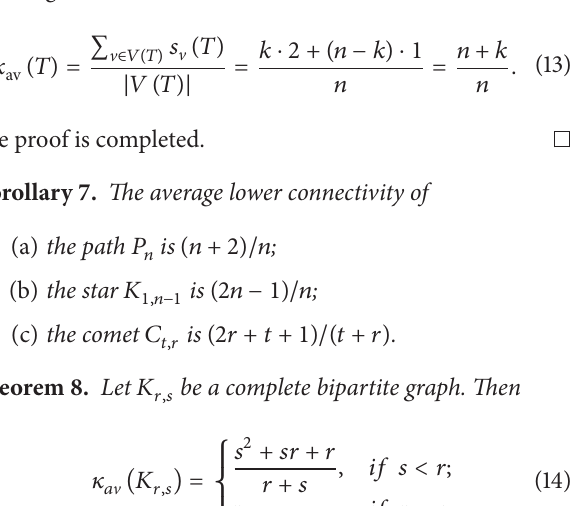
Figure 4: The gear graph 𝐺